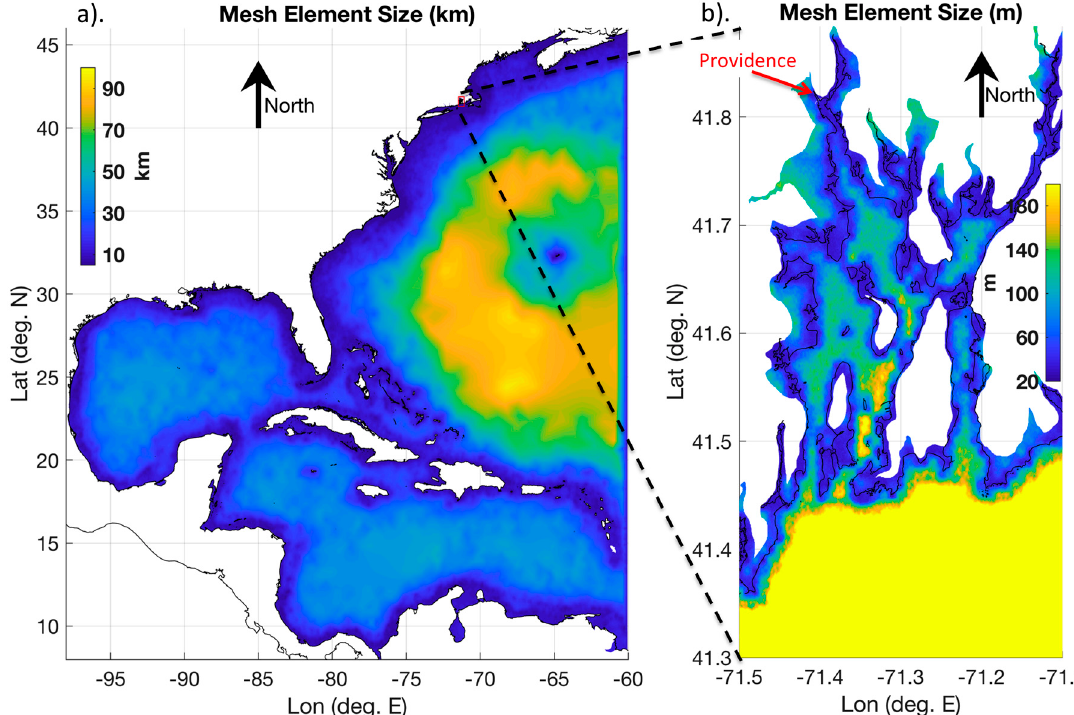
Figure 1. ADvanced CIRCulation (ADCIRC) mesh element size for ( a ) full domain in kilometers, and ( b ) Narragansett Bay (Rhode Island) region in meters.